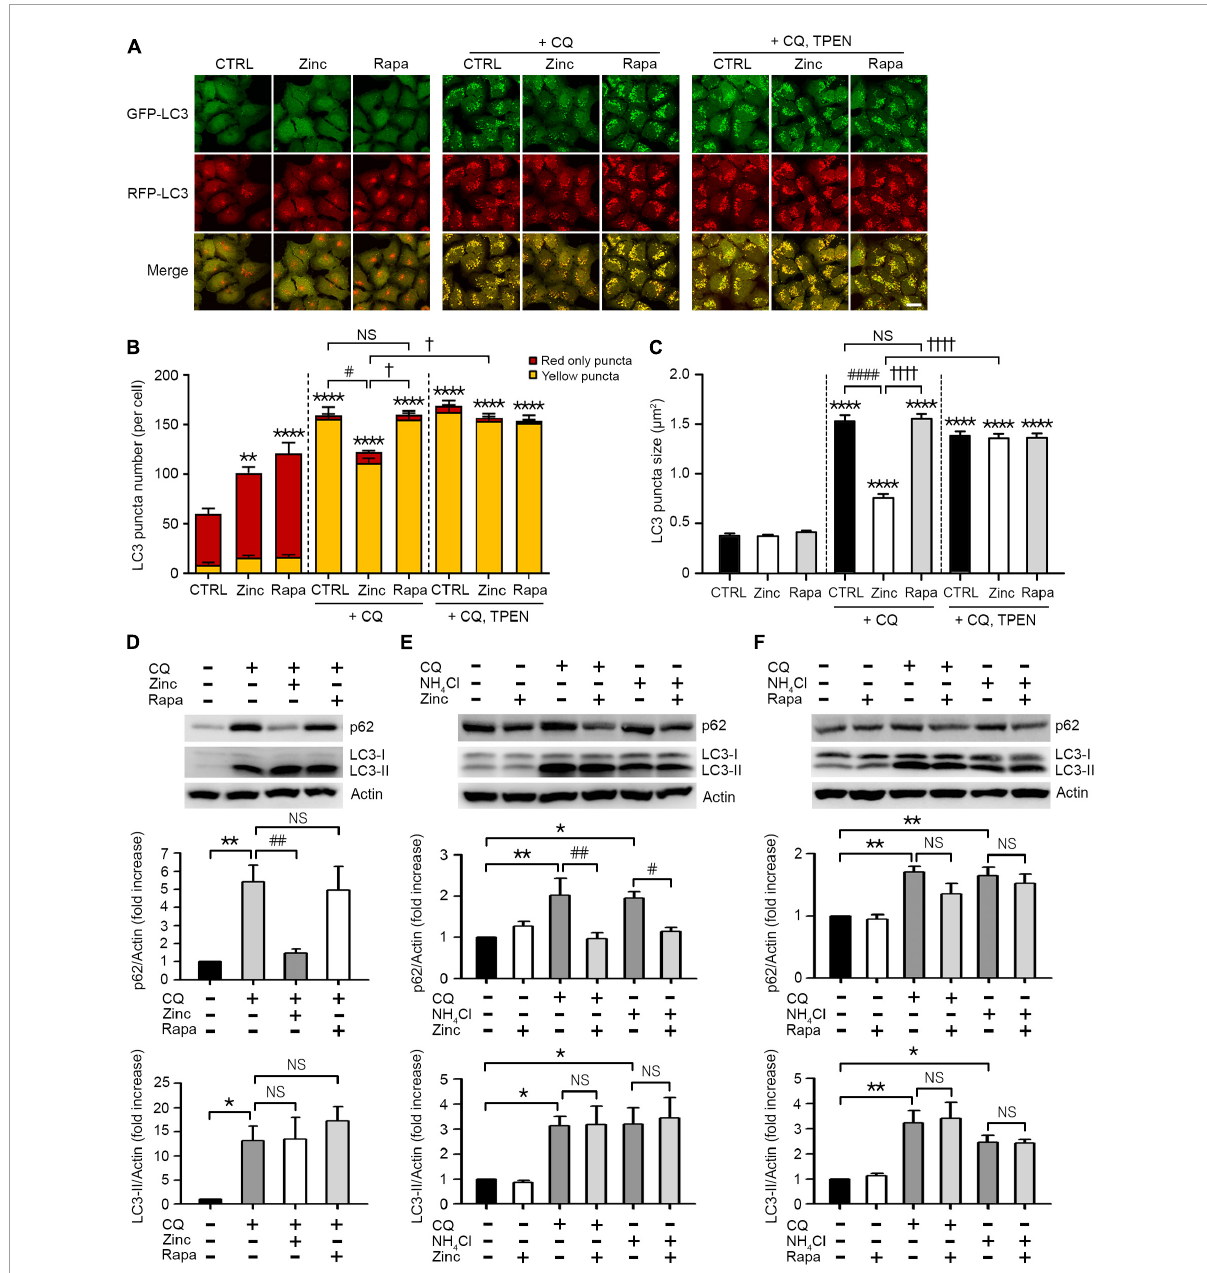
FIGURE2 Zinc rescues the blockade of autophagic flux. (A) Fluorescence confocal microscopy images of mRGL-H4 cells 12 h after sham wash (CTRL) or exposure to 50 µ M ZnCl 2 (Zinc) or 100 nM rapamycin (Rapa) in the presence or absence of 50 µ M chloroquine (CQ) or CQ plus TPEN (+CQ, TPEN). Scale bar 25 µ m. (B,C) Quantitative analysis of RFP-GFP-LC3 puncta observed 12 h after exposure to zinc or rapamycin (Rapa) in the presence or absence of chloroquine (CQ) or CQ plus TEPN (+CQ, TPEN). The bar graphs represent the total number of RFP-GFP-LC3 puncta including red-only and yellow puncta per cell (B) and the mean size of red-only and yellow puncta (C) (mean ± SEM, n = 12 different fields taken from ≥ 3 independent biological replicate experiments). ** p < 0.01 or **** p < 0.0001 vs. sham wash CTRL, # p < 0.05 or #### p < 0.0001 vs. CQ alone, and † p < 0.05 or †††† p < 0.0001 vs. CQ + zinc by ANOVA with post hoc Dunnett’s test. There was no significant difference between CQ alone and CQ plus rapamycin (NS). (D) Western blot analysis for p62 and LC3 in mRGL-H4 cells. Protein samples were prepared at 9 h after exposure to sham wash (CTRL), or 50 µ M chloroquine with or without 50 µ M ZnCl 2 (Zinc) or 100 nM rapamycin (Rapa). Quantification of the expression level of p62 and LC3-II was performed in ≥ 3 independent biological replicate experiments. * p < 0.05 or ** p < 0.01 vs. sham wash CTRL, and ## p < 0.01 vs. CQ alone by ANOVA with post hoc Dunnett’s test. There was no significant difference between CQ alone and CQ plus rapamycin (NS). (E,F) Western blot analysis for p62 and LC3 in mouse cerebrocortical cultures. Protein samples were prepared at 12 h after exposure to sham wash (CTRL), 50 µ M chloroquine (CQ), or 5 mM ammonium chloride (NH 4 Cl) in the presence or absence of 25 µ M